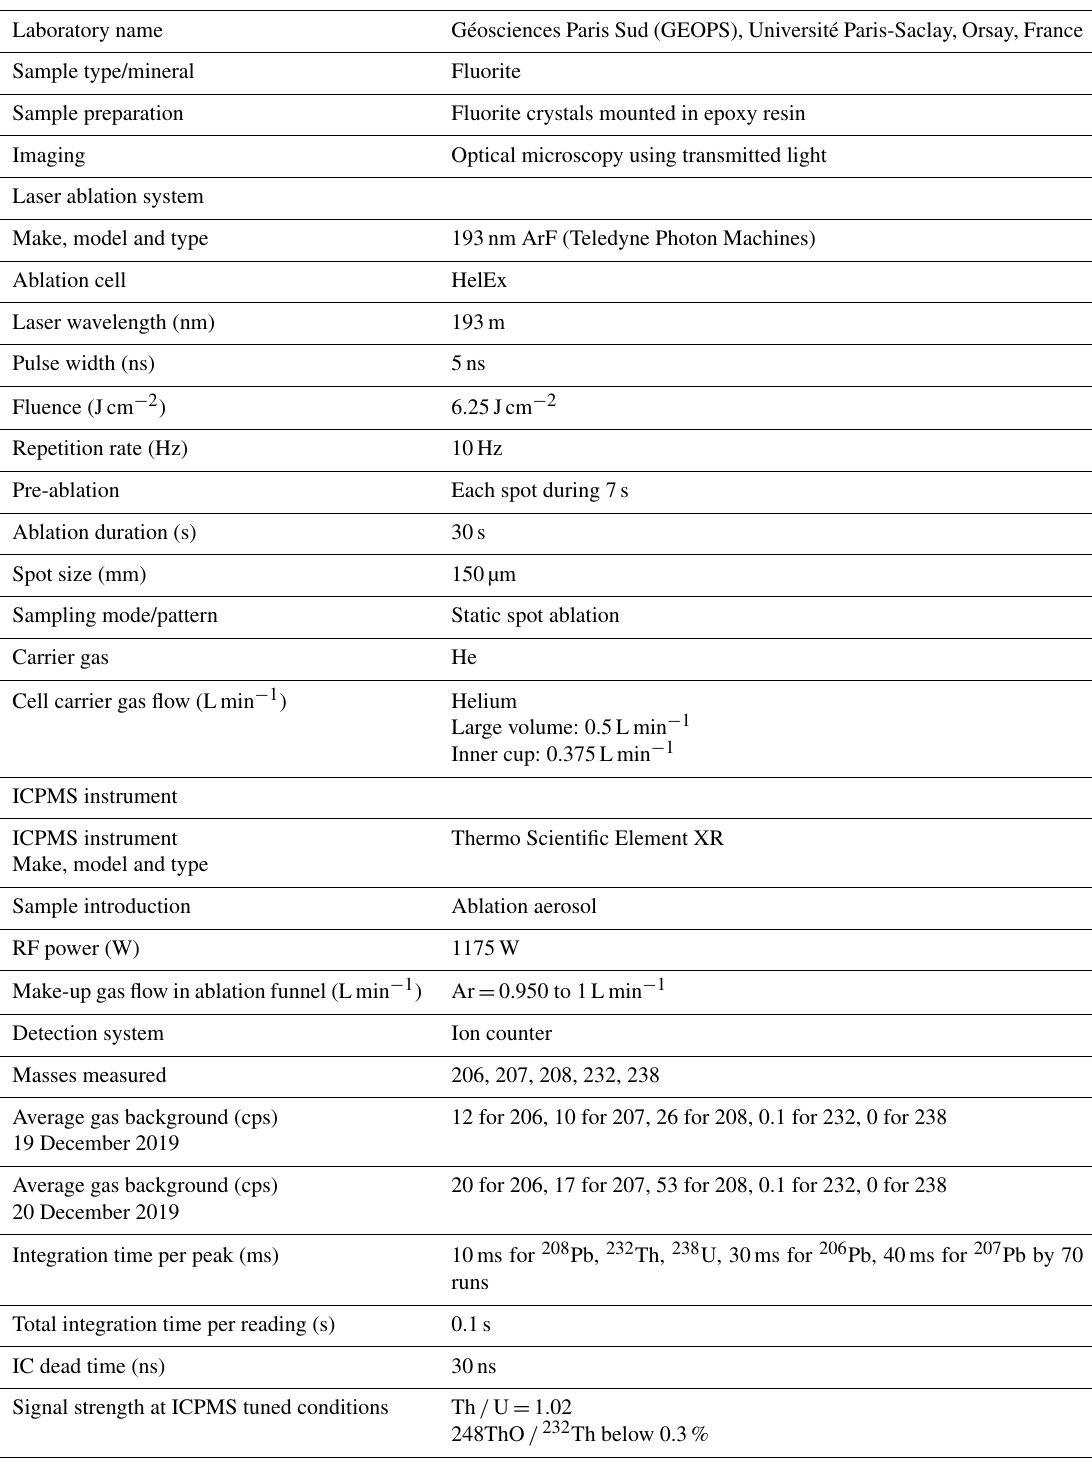
Table A4. Data for fluorite LA-ICP-MS U–Pb analysis at University Paris-Saclay, GEOPS